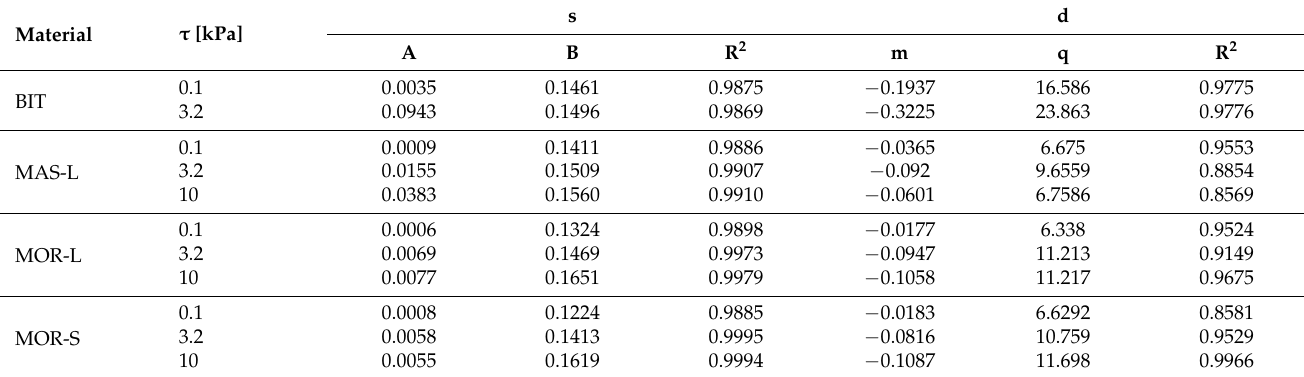
Table 6. Physical parameters describing creep-recovery strain